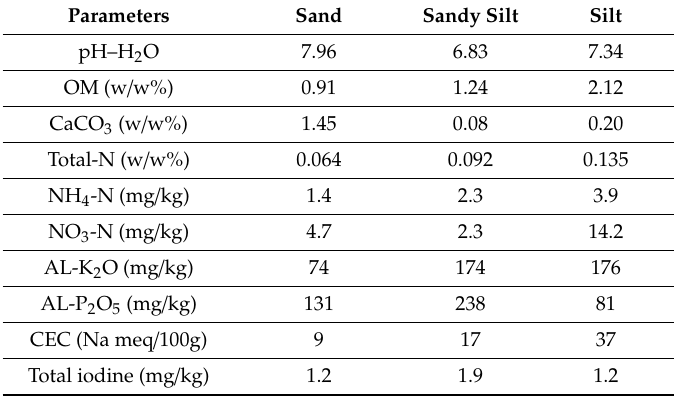
Table 1. Physical-chemical properties of